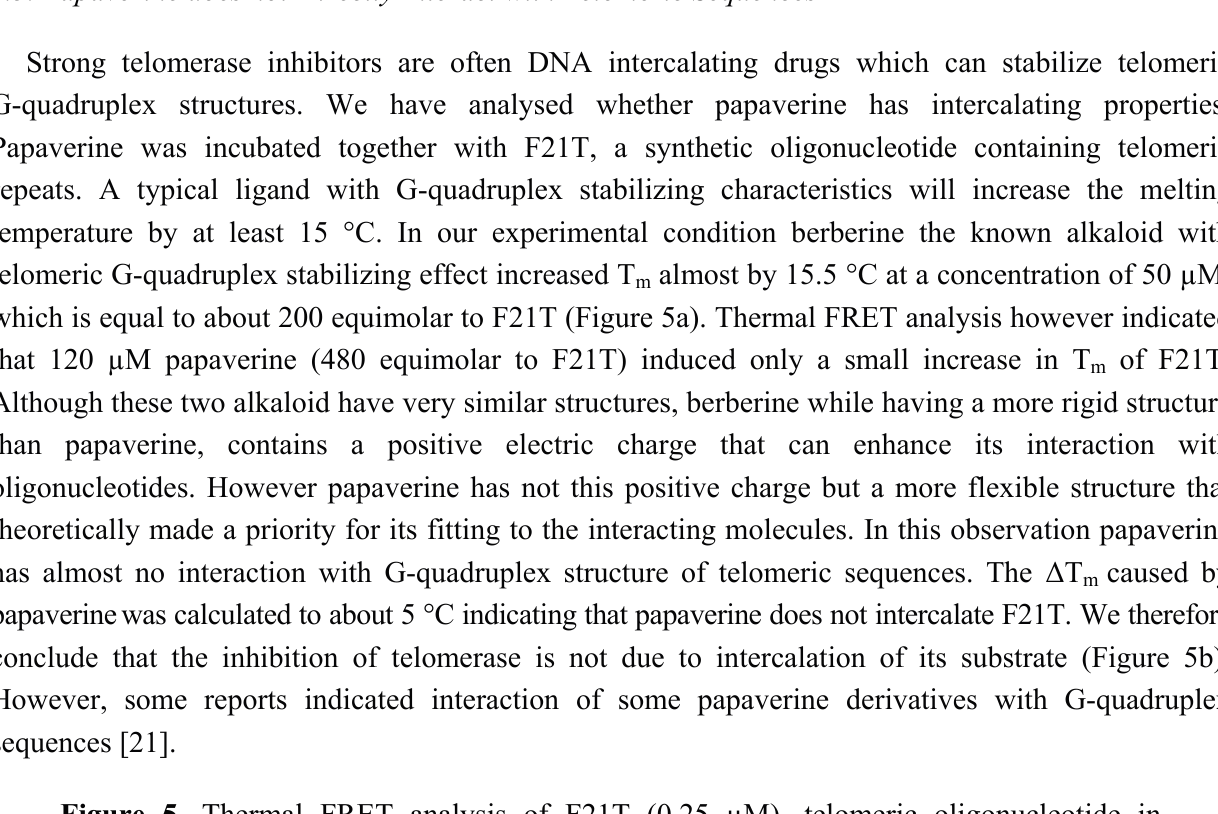
Figure 5. Thermal FRET analysis of F21T (0.25 µM), telomeric oligonucleotide in presence of increasing amounts of alkaloids. Fluorescence intensity versus temperature in presence of berberine ( a : Black 0, dark gray 2.5, gray 25, light gray 50 µM) and papaverine ( b : Black 0, dark gray 7.5, gray 30, light gray 120 µM) in potassium cacodylate buffer. ( a